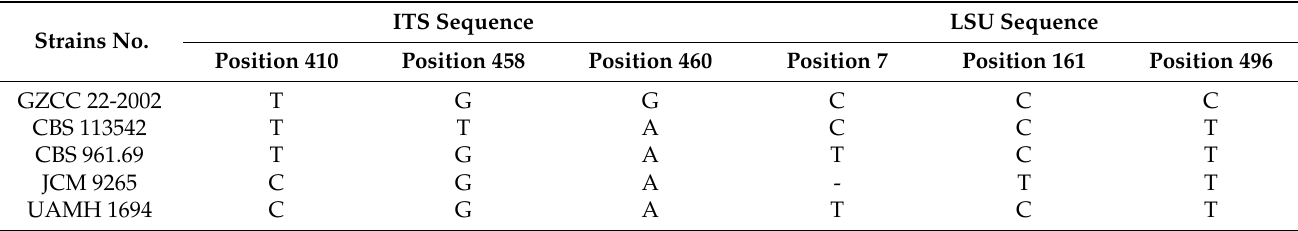
Table 1. Nucleotide differences between the new isolate and the other four known isolates of Helicosporium griseum in the ITS and LSU regions.